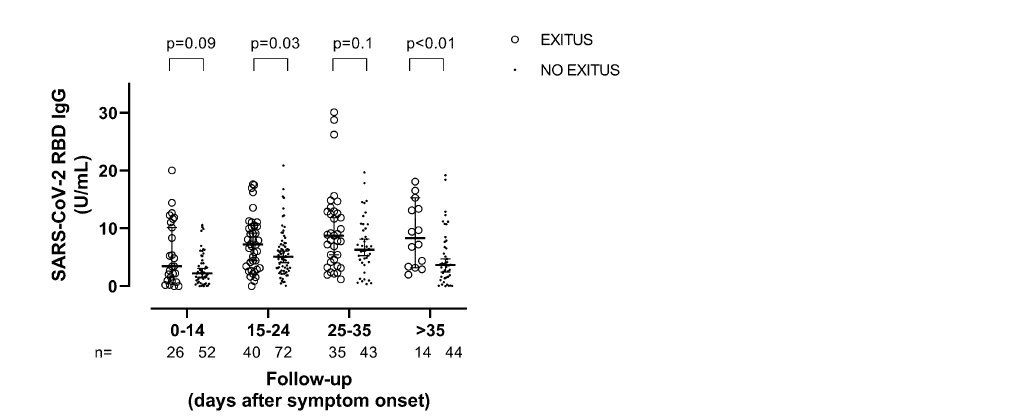
Figure 3. Kinetics of SARS-CoV-2 S1/M-reactive IFN-γ CD8 + ( A ) and CD4 + ( B ) T-cell responses in critically ill COVID-19 patients who died or survived, as determined by flow cytometry for intracellular staining at different arbitrarily defined time frames since symptom onset. Bars represent medians and 95% CI values. P values for comparisons are shown.